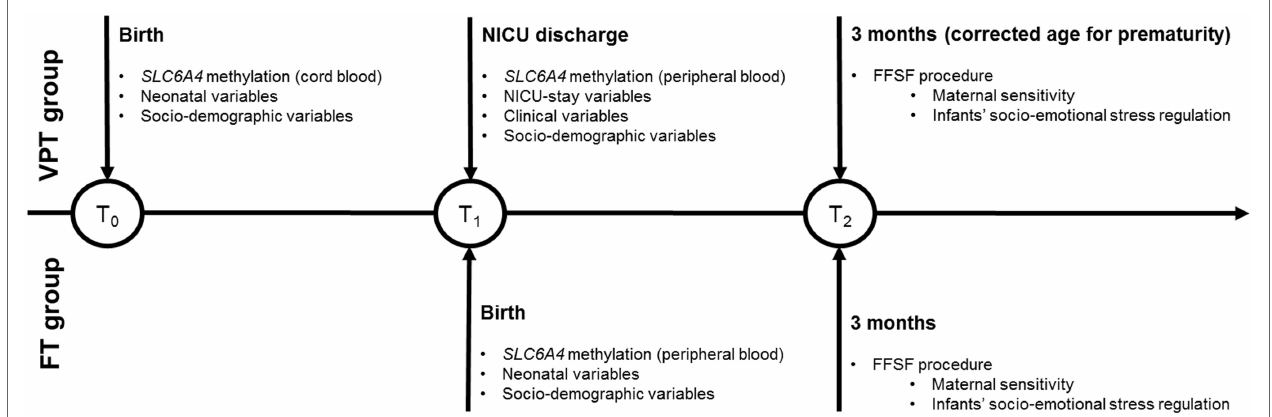
FigUre 1 | Overview of the PBE longitudinal research project. Note. VPT, very preterm; FT, full-term; NICU, Neonatal Intensive Care Unit; FFSF, Face-to-Face